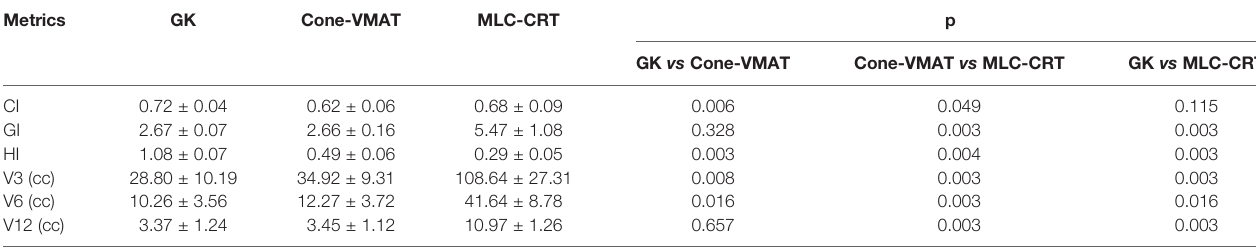
TABLE 3 | Comparison of dosimetric parameters from different plans.